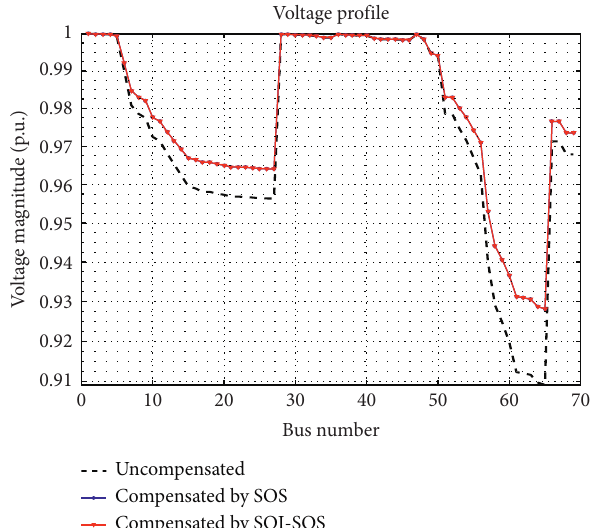
Figure 10: Voltage profile of the 69-bus system before and after compensation with the CP load model at 100% loading.